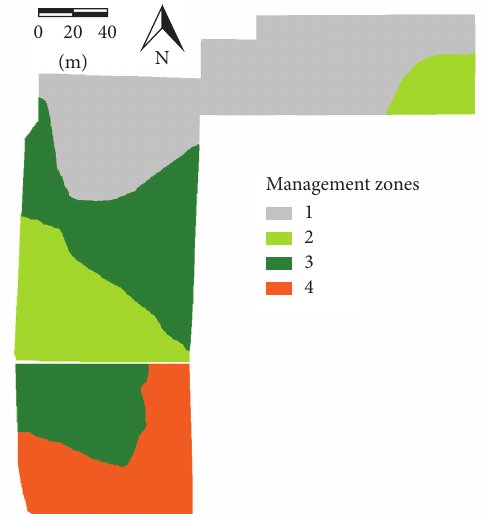
Figure 7: Spatial distribution of the content of fine minerals (clay, silt, and fine sand) in Ap horizon for the study area.